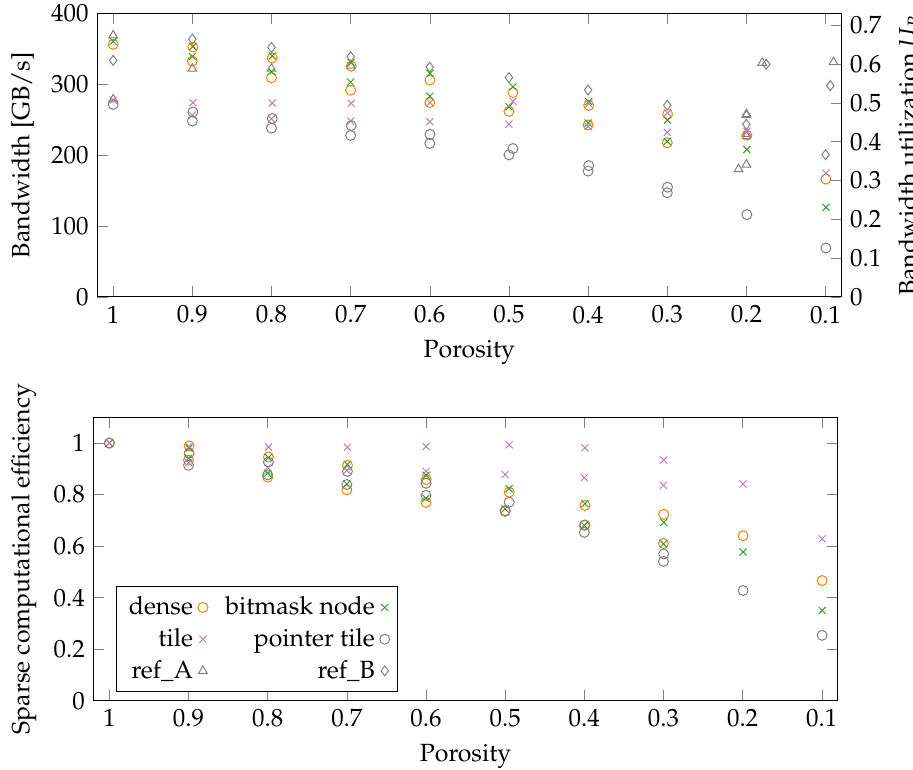
Figure 8. Performance of GPU simulations ( top ) and sparse performance efficiency ( bottom ) for single-precision numbers, different data layouts, and sparse geometries with 4096 2 nodes and different porosities. For a given data layout, the lower sequence of points shows performance for regularly placed circles, and the upper points correspond to performance for randomly placed circles. Reference performance for tile-based implementations optimised for sparse geometries is adapted from [16] (ref_A) and [17] (ref_B), accordingly. Performance for implementation from [17] is for GTX Titan Xp, D3Q19 lattice arrangement and single-precision numbers, whereas work [16] uses double-precision, both D2Q9 and D3Q19 lattices, and different GPU (GTX TITAN) thus positions of markers (triangles) result from U B